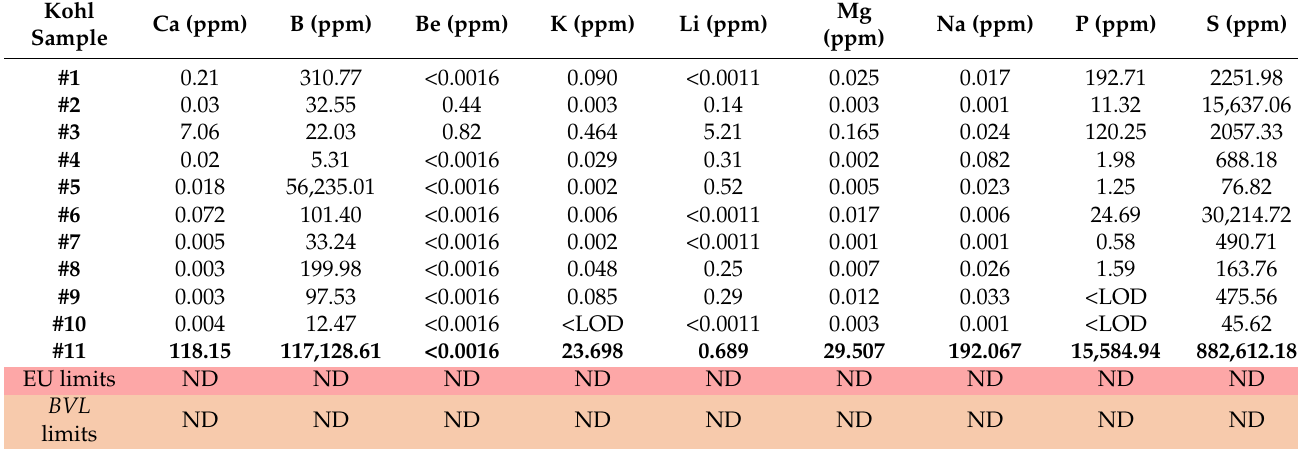
Table 6. Concentrations of elements ( ppm or µ g/g for B , Be , and Li and g/100 g for Ca , Mg , K , Na , P , and S ) in kohl samples compared to the limitations established by governmental institutions. Orange boxes indicate values above the German Federal Office of Consumer Protection and Food Safety ( BVL ) [45,46] limits. Red boxes show levels which exceed the European Union legal limits [40]. LOD: limit of detection. ND : not described.